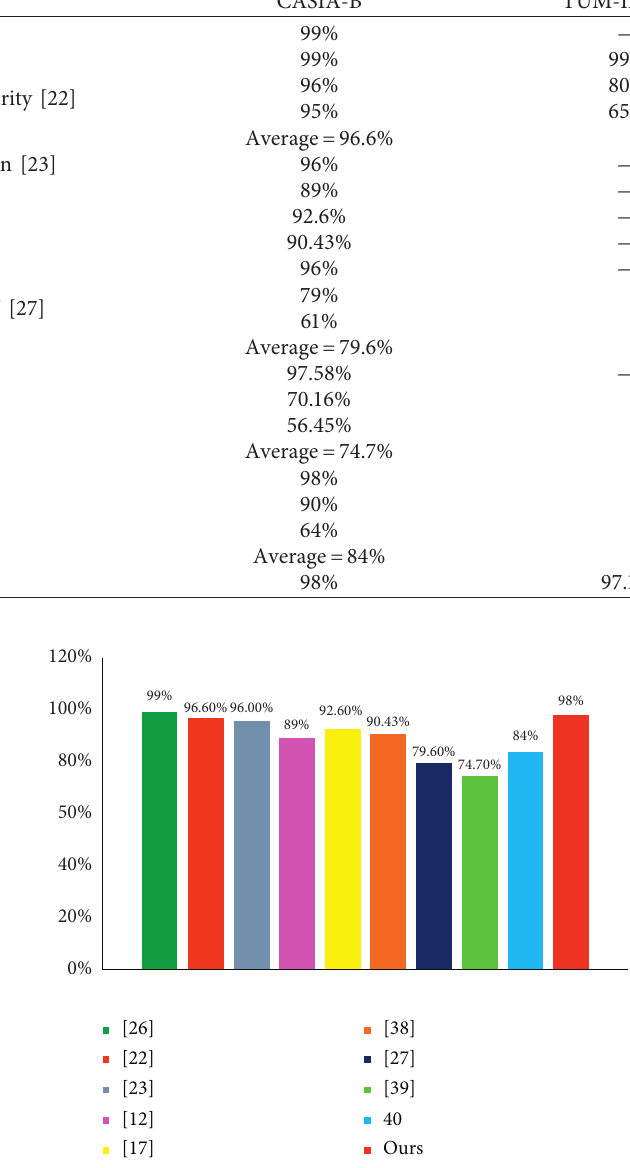
Figure 19: The performance evaluation of existing and presented work on CASIA-B.